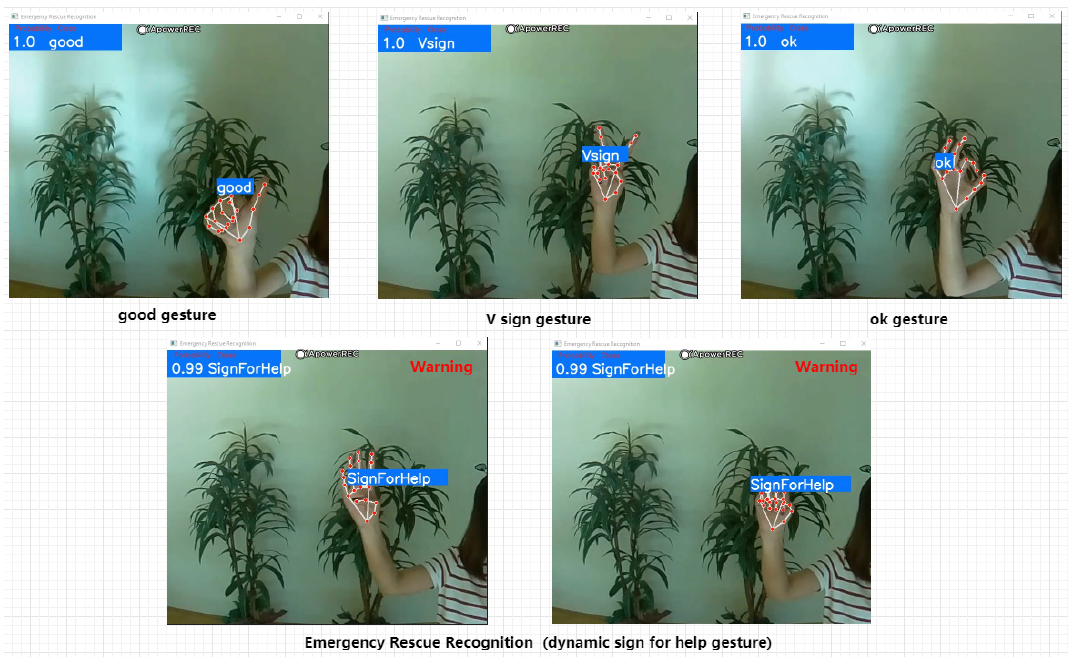
Figure 15. Demonstration of the results of simulated wilderness environments for emergency rescue recognition.